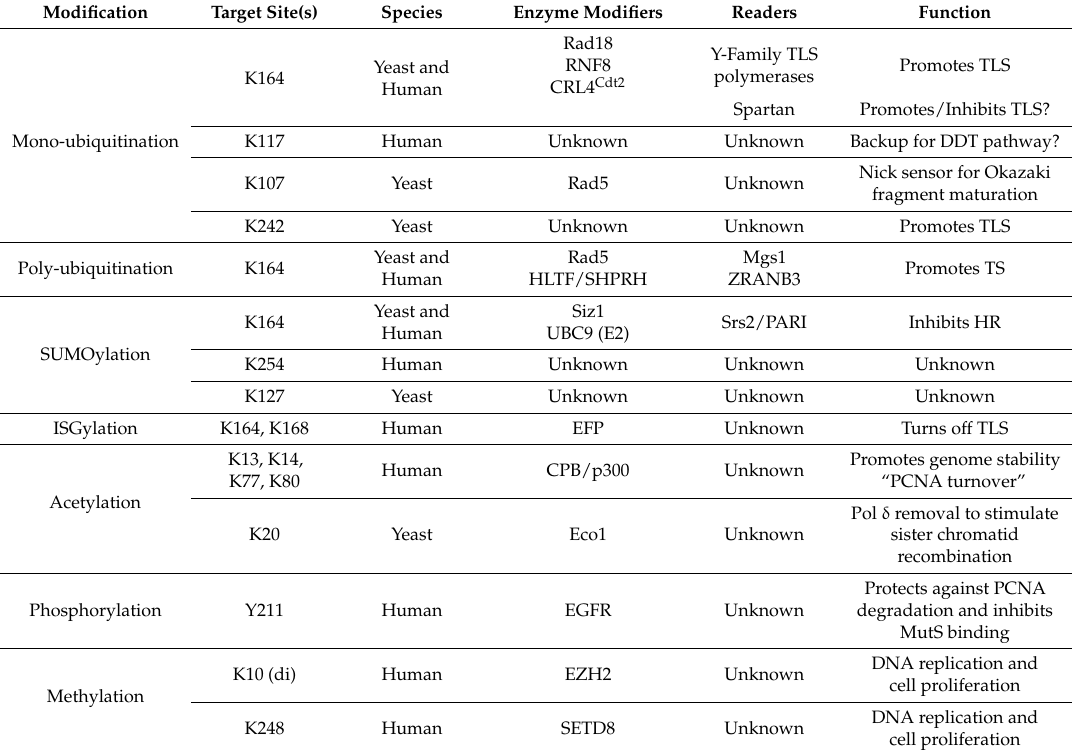
Table 1. Post-translational modifications of